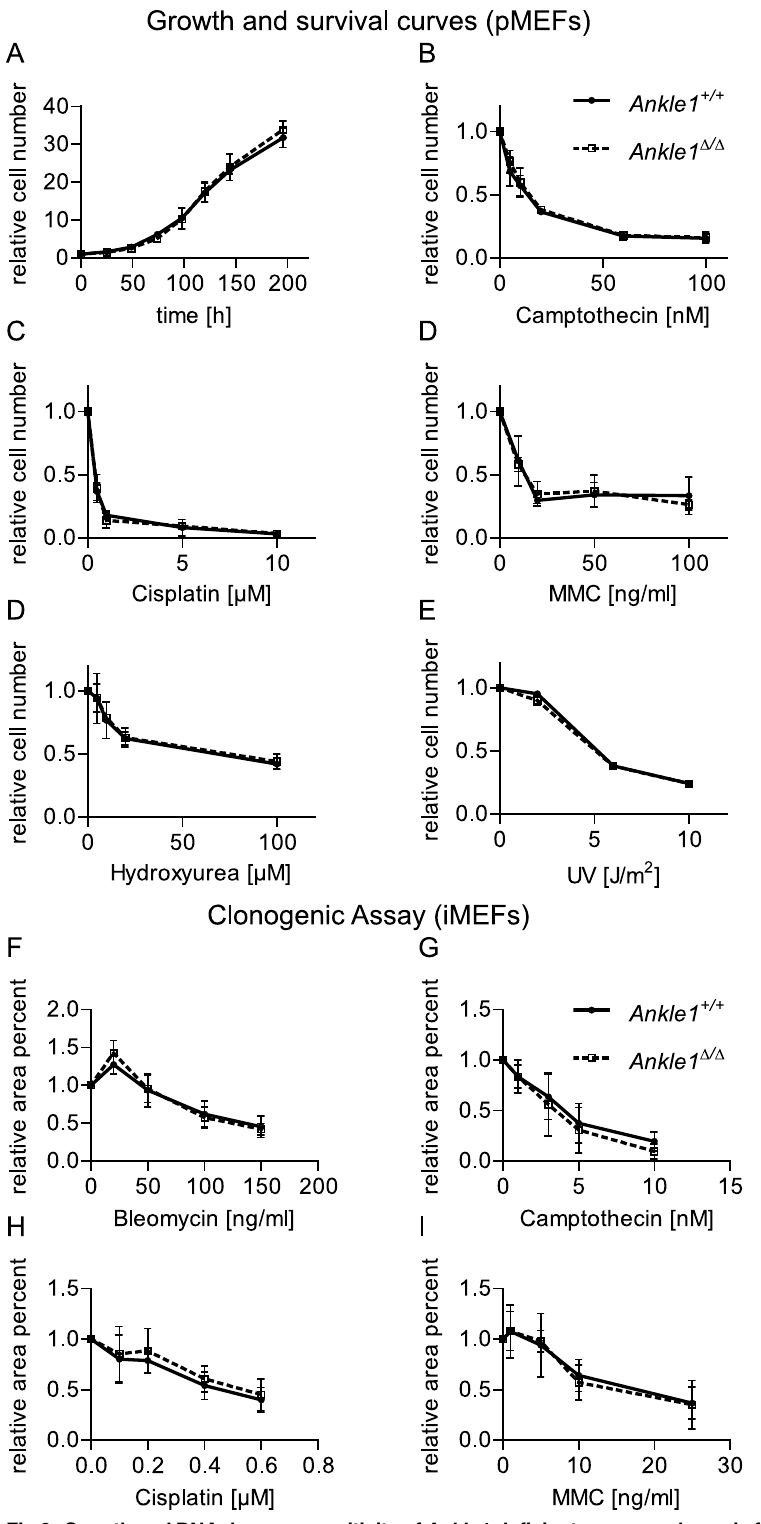
Fig 6. Growth and DNA damage sensitivity of Ankle1 -deficient mouse embryonic fibroblasts (MEFs). (A) Growth curve of primary MEFs (pMEFs), n = 3, error bars: standard deviation; (B-D) Survival of pMEFs after chronic exposure to indicated DNA damaging agents for 72 h, n = 3, error bars: standard deviation;